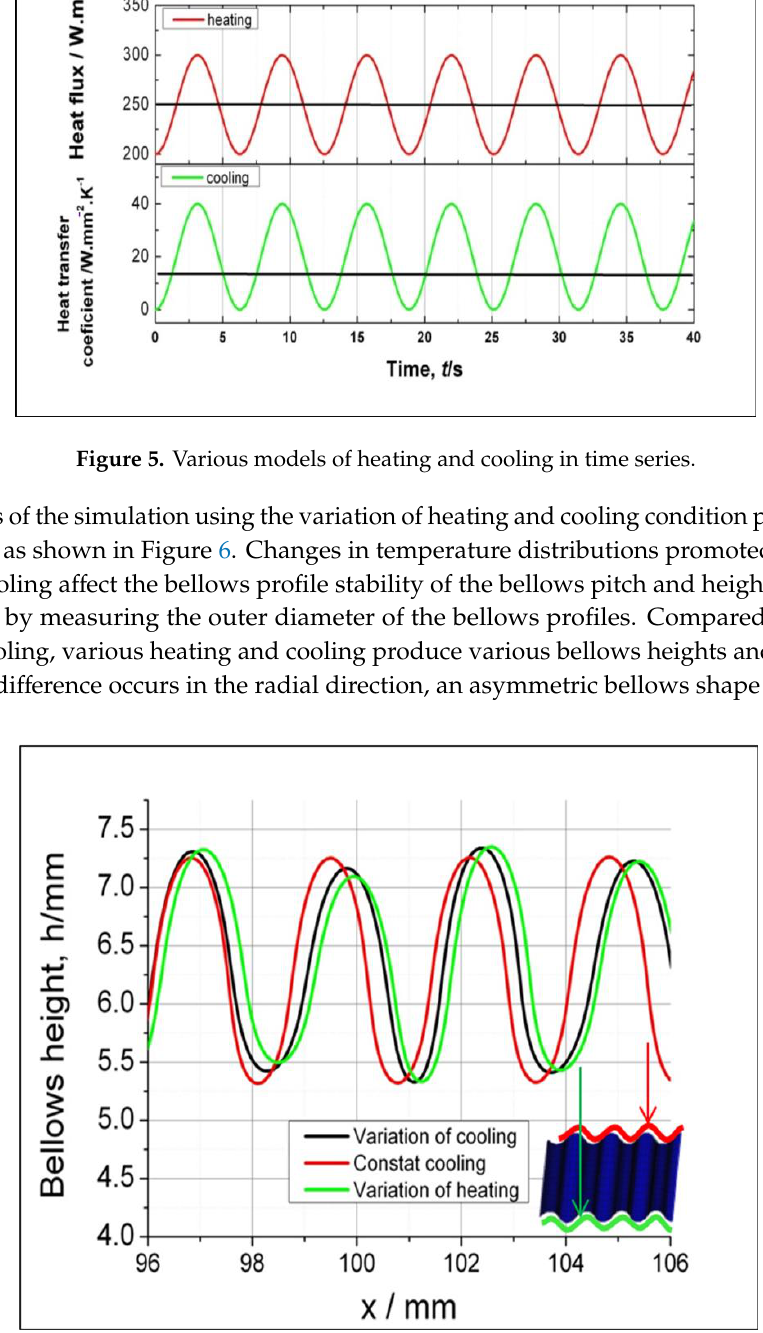
Figure 6. Bellows profiles under different conditions.